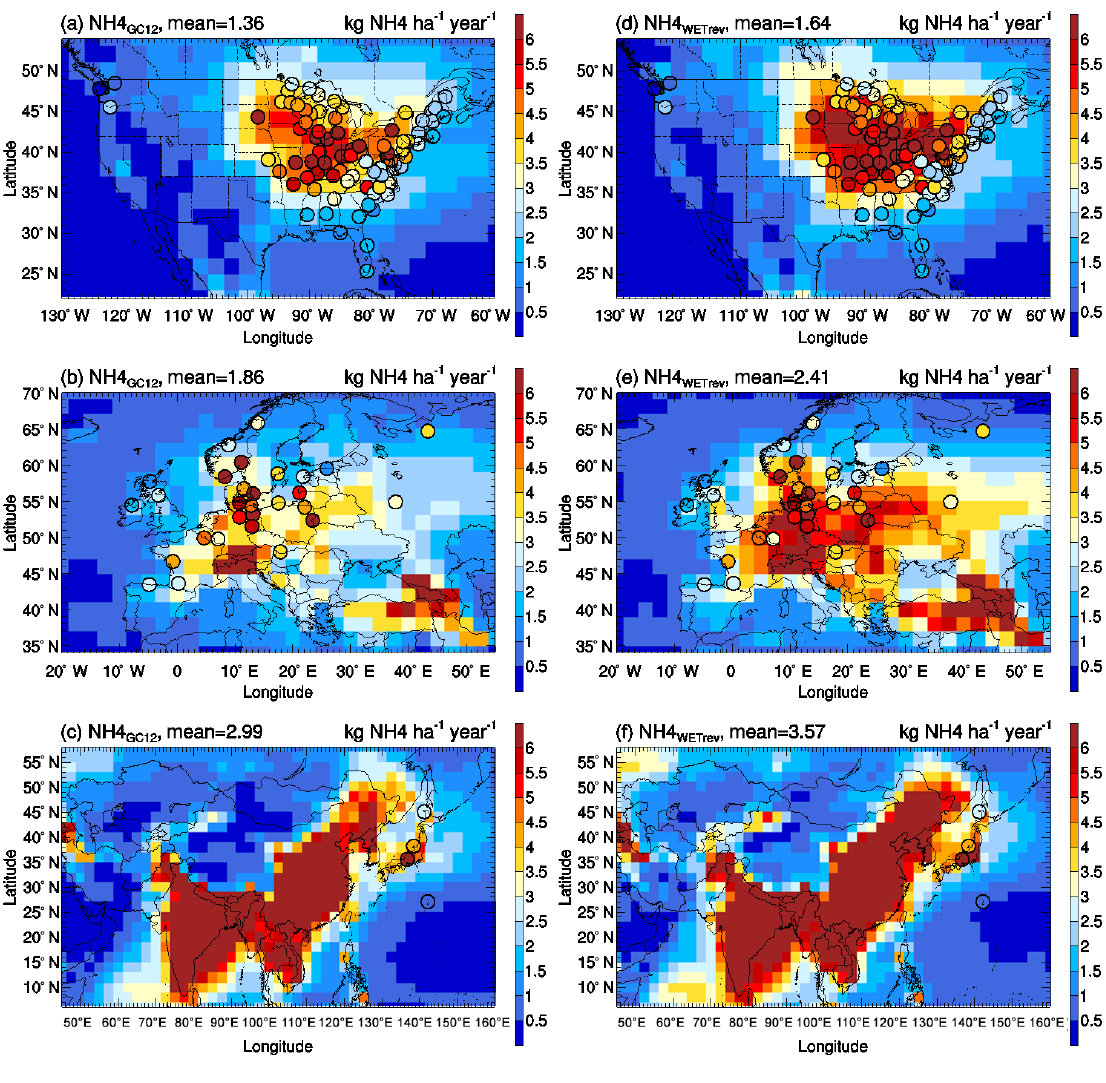
Figure 5. The same as Fig. 3 but for NH 3 + NH 4 .